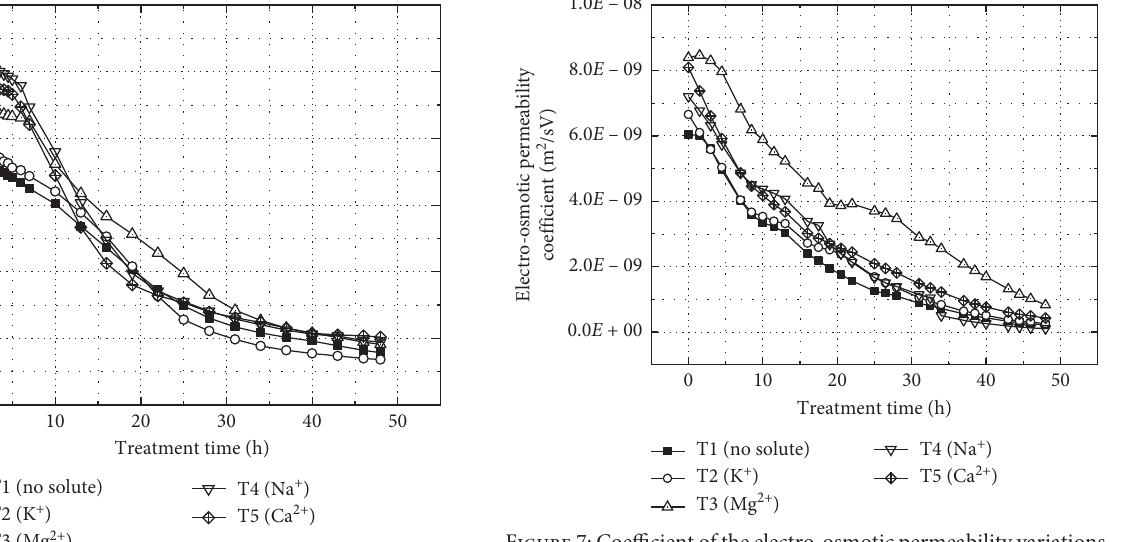
Figure 7: Coefficient of the electro-osmotic permeability variations over treatment